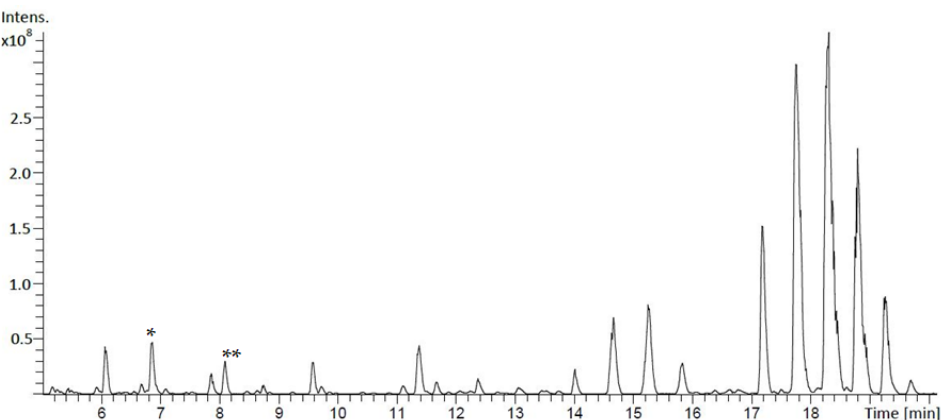
Figure 2. LC-MS chromatogram of the butanol extract of Streptomyces aurantiacus LU19075 cultivated in DNPM medium showing the peaks of bosamycins B, C, and D (*) and depsibosamycins B, C, and D (**). In addition to that, nactins (17–20 min) and nactin degradation products (9–16 min) were